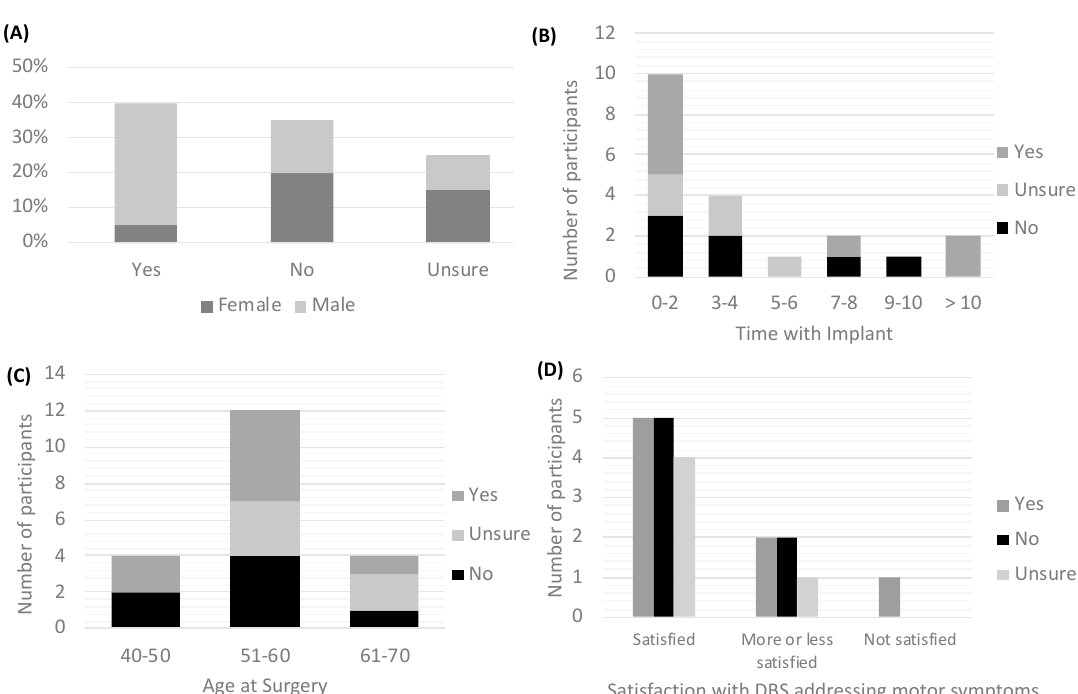
Figure 1. Factors driving patients’ responses about having DBS earlier. ( A ) Percentage of responses by gender; ( B ) Number of participants’ responses by time with implant; ( C ) Number of participants’ responses by age at DBS surgery; ( D ) Number of participants’ responses by level of satisfaction with DBS addressing motor symptoms.